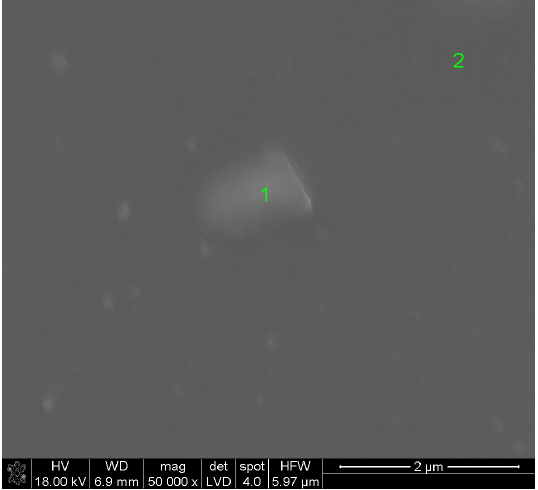
Figure 7. Surface of the layer synthesized at 550 °C. The molar percentage of Sm(tmhd) 3 was about 14%. Synthesis time: 20 min. Other synthesis parameters: same as in the case of the sample from Figure 1. Table 3. Quantitative EDS analysis results obtained from point 1 on the surface of the sample presented in Figure 7 (data only for Zr and Sm)